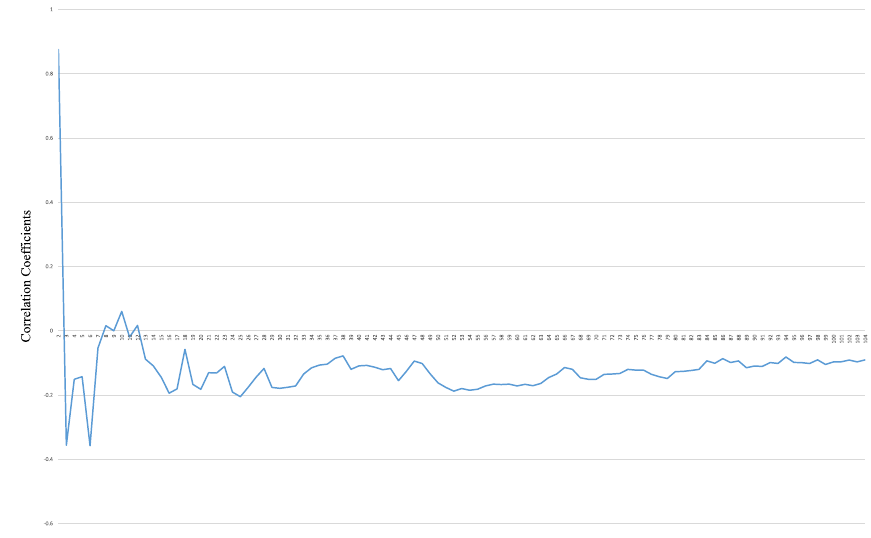
Fig. 1 Association between mutation location and malaria genetic marker with respect to correlation coefficients and feature sets based on Spearman correlation coefficient